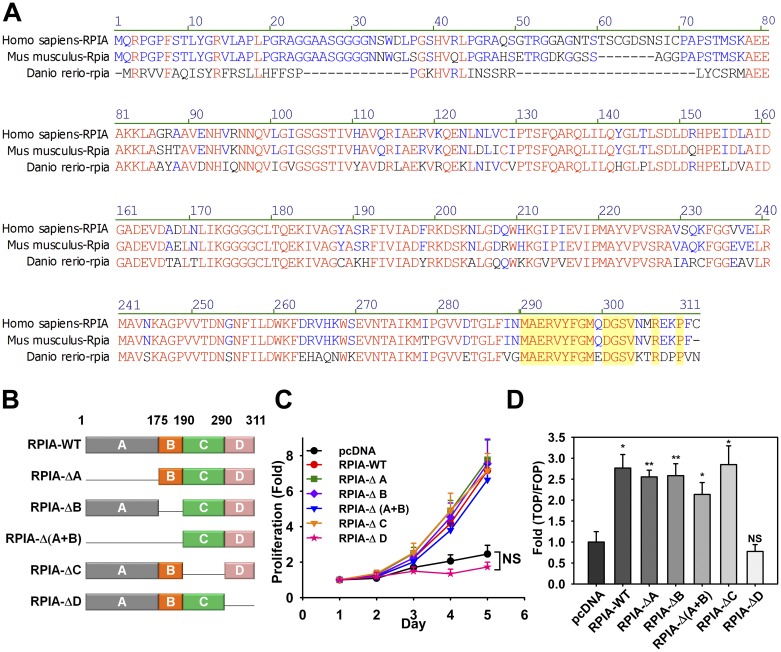
The C-terminal domain of RPIA containing amino acids 290 to 311 is required for cell proliferation and β-catenin stabilization in HCT116 cells.(A) The RPIA amino acid sequence in several species. Identical sequences are represented by red text. Blue text indicates >50% but <90% consensus. Yellow background indicates RPIA domain D. The analysis was conducted with Vector NTI-AlignX. (B) Schematic representation of RPIA and its deletion mutants. RPIA-WT; RPIA-ΔA, deletion of the A domain from amino acid 1 to 174 containing the isomerase active site in the N-terminus; RPIA-ΔB, deletion of the B domain from amino acid 175 to 189 containing the catalytic residue; RPIA-Δ (A+B), deletion of the A and B domains from amino acid 1 to 189; RPIA-ΔC, deletion of the C domain from amino acid 190 to 289; RPIA-ΔD, deletion of the D domain from amino acid 290 to 311 in the C-terminus of RPIA. (C) The effect on cell proliferation after the expression of RPIA-WT and the different RPIA deleted constructs in HCT116 cells. (D) RPIA-ΔD lost the ability to stimulate the TOPflash luciferase construct in HCT116 cells. The statistical significance was calculated with Student t test (* 0.01 < P < 0.05 and ** 0.001 < P < 0.01). Data can be found in S4 Data. NS, not significant; pcDNA, pcDNA3 vector control; RPIA, ribose-5-phosphate isomerase A; RPIA-WT, RPIA wild type.